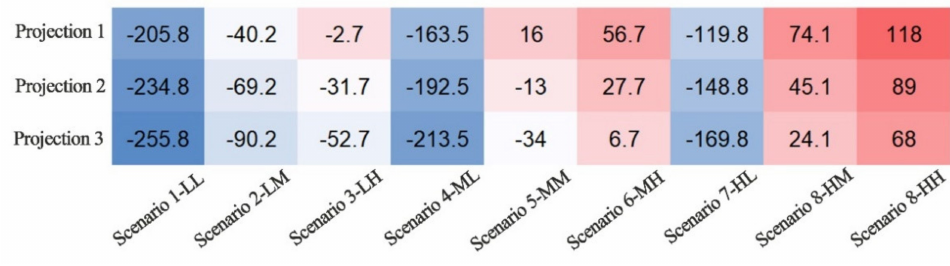
Figure 7. The gaps of demand scenarios and production projection in 2050. If demand is greater than production, the gap is positive and denoted in red. Conversely, if demand is less than production, the gap is negative, indicated in